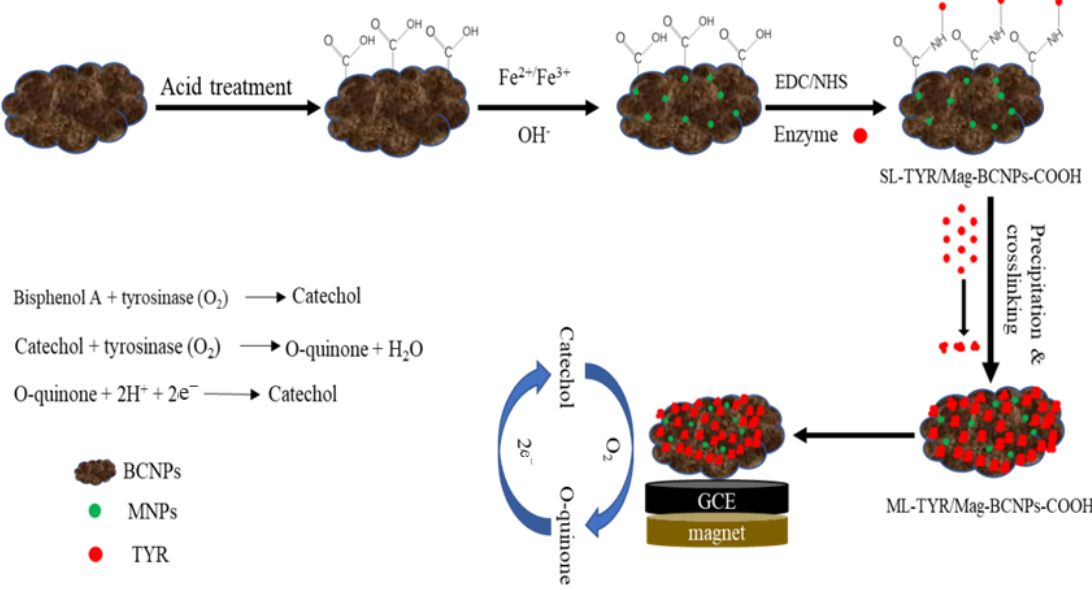
Figure 4. General scheme for the sensor fabrication proposed by He and coworkers [110]. Permis ‐ Figure 4. GeneralschemeforthesensorfabricationproposedbyHeandcoworkers[110]. sion request.